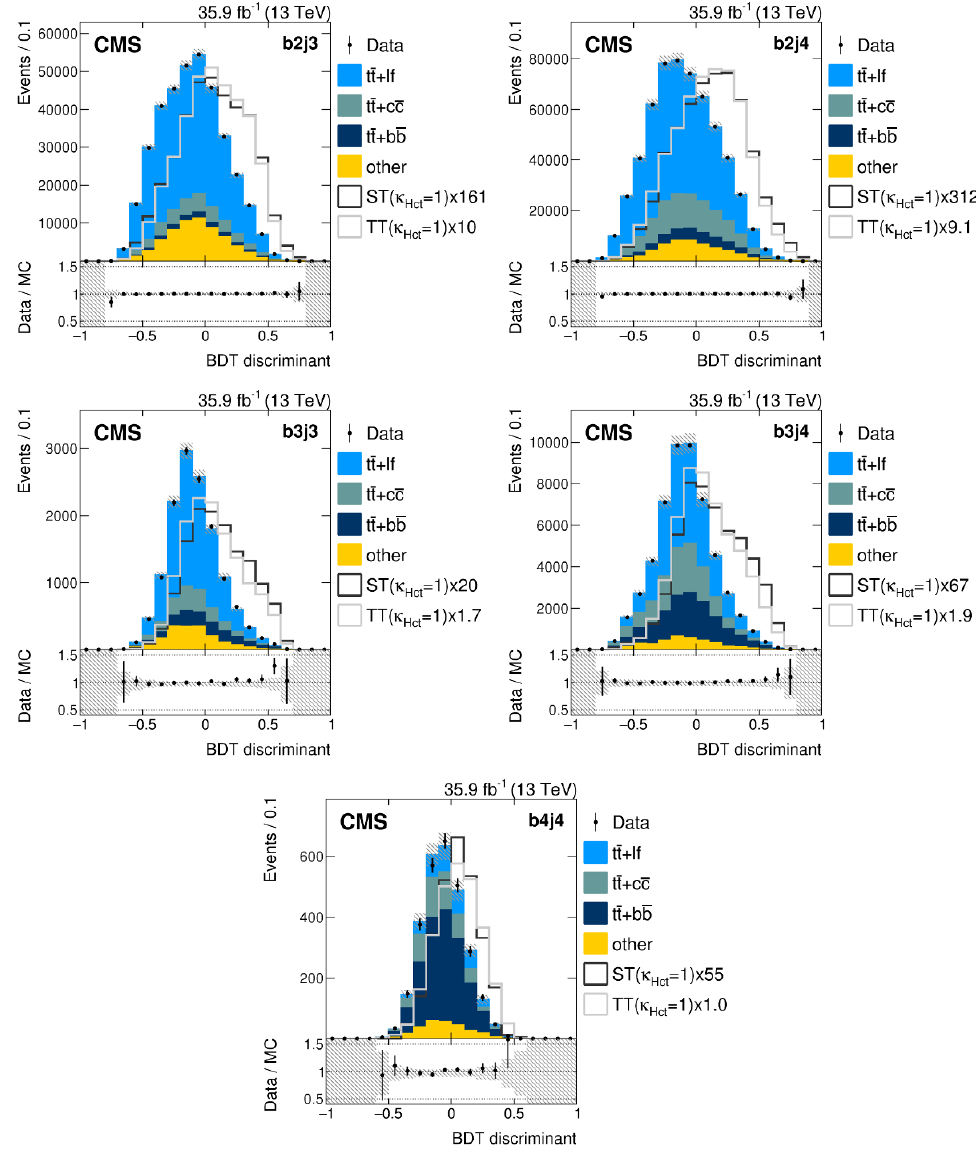
Figure 4 . The BDT discriminant distributions for di(cid:11)erent jet categories for Hct training after the (cid:12)t to data. All background processes are constrained to the SM expectation in the (cid:12)t. The shaded area corresponds to the total uncertainty in the predicted background. The data-to-simulation ratio is also shown. The distributions for the signal processes are normalized to the total number of events in the predicted background to ease the comparison of the shapes of the distributions.